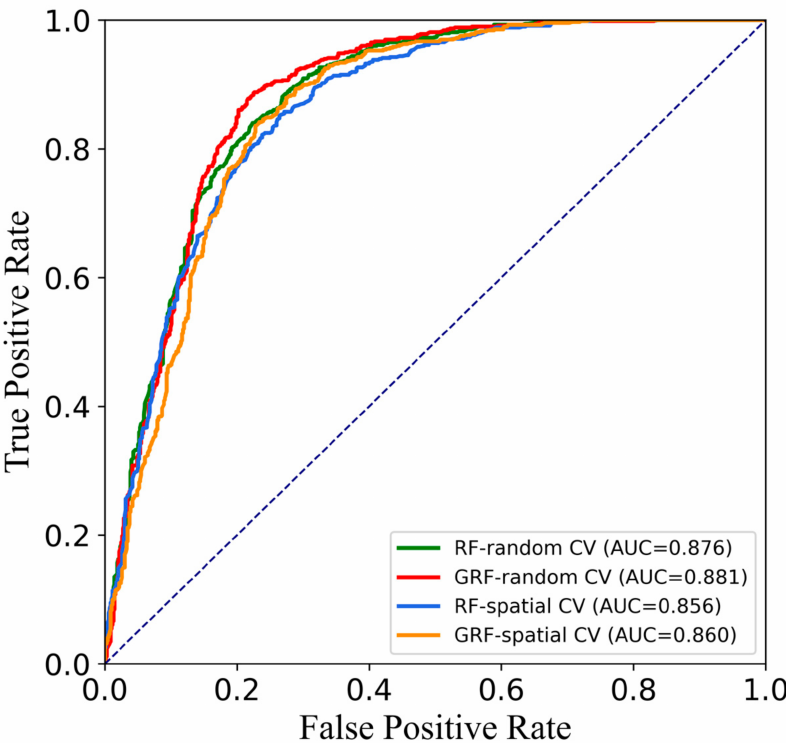
Figure 4. ROC curves of RF and GRF on the validation data using random CV and spatial